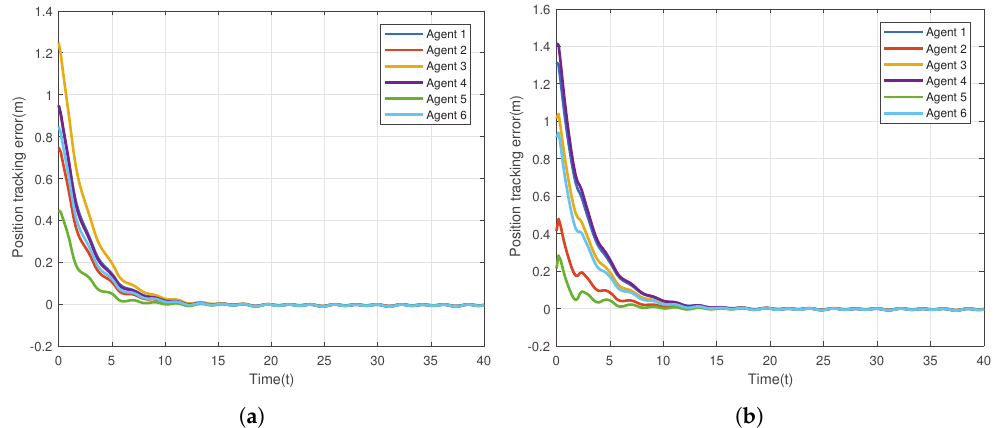
Figure 2. Position tracking errors of 6 agents in the networked Euler-Lagrange system. ( a ) Position tracking errors for X-axis; ( b ) Position tracking errors for Y-axis.